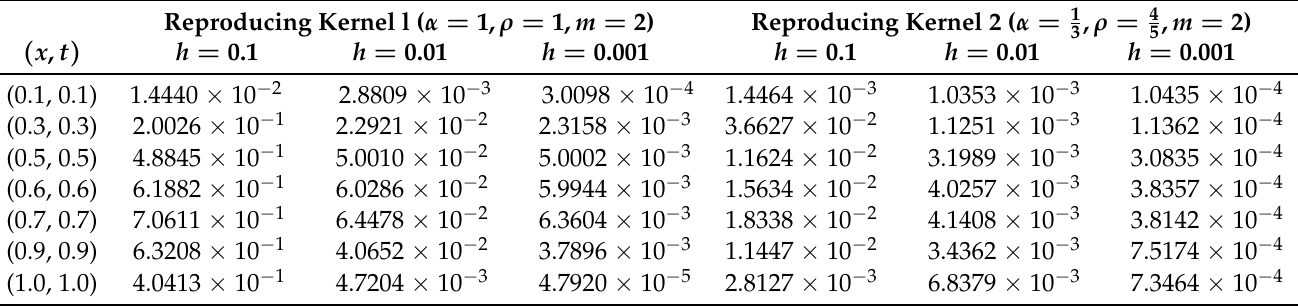
Figure 3. The logarithm of the absolute error at different reproducing kernel spaces t = 0.01. ( a ) The logarithm of the absolute error in reproducing kernel space l ( α = 1, ρ = 1, m = 2). ( b ) The logarithm of the absolute error in reproducing kernel space 2 ( α = 1 Table 2. Comparison of the absolute errors for Experiment 1 at t = 0.1 (Two forms of the reproducing kernel